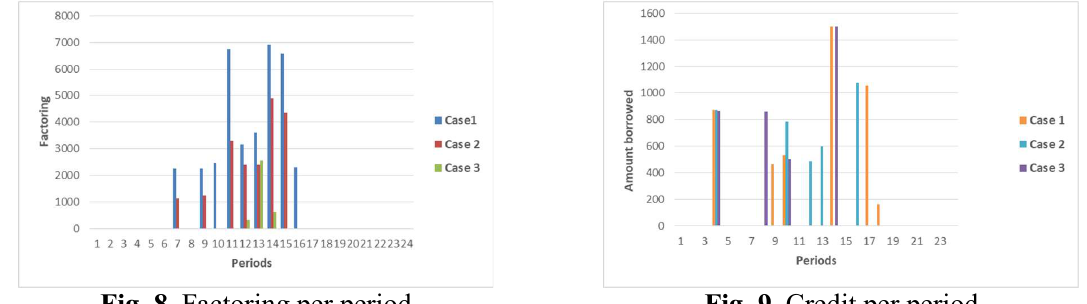
Fig. 8. Factoring per period Fig. 9. Credit per period